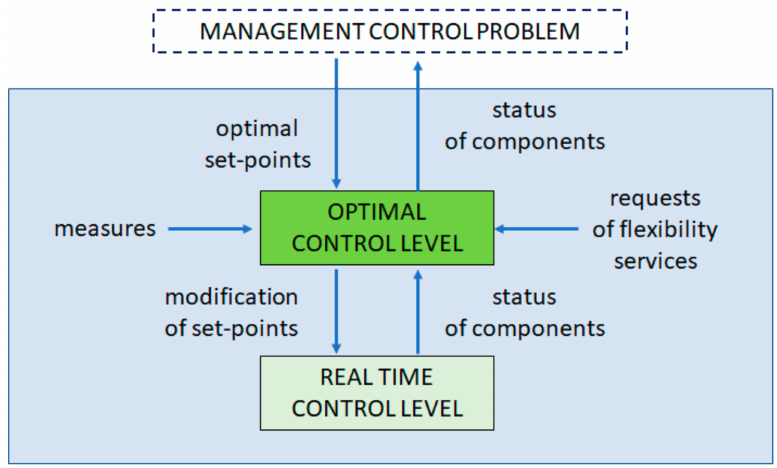
Figure 9. Representation of the optimal